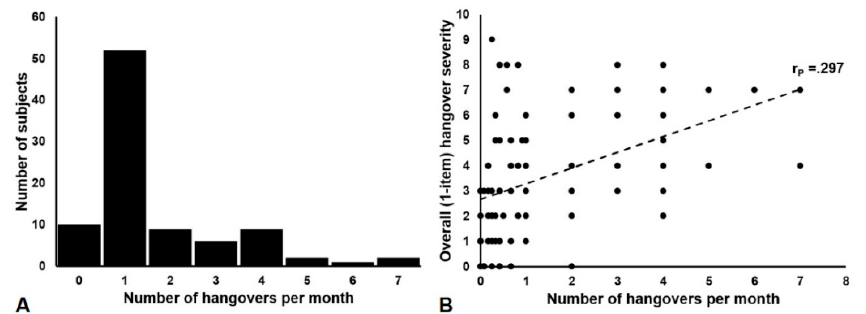
Figure 1. Distribution of the hangover frequency scores ( A ) and their association with the overall hangover severity ( B ). Note: a partial correlation ( r P ), adjusting for estimated blood alcohol concentration, was computed between the hangover frequency and severity.